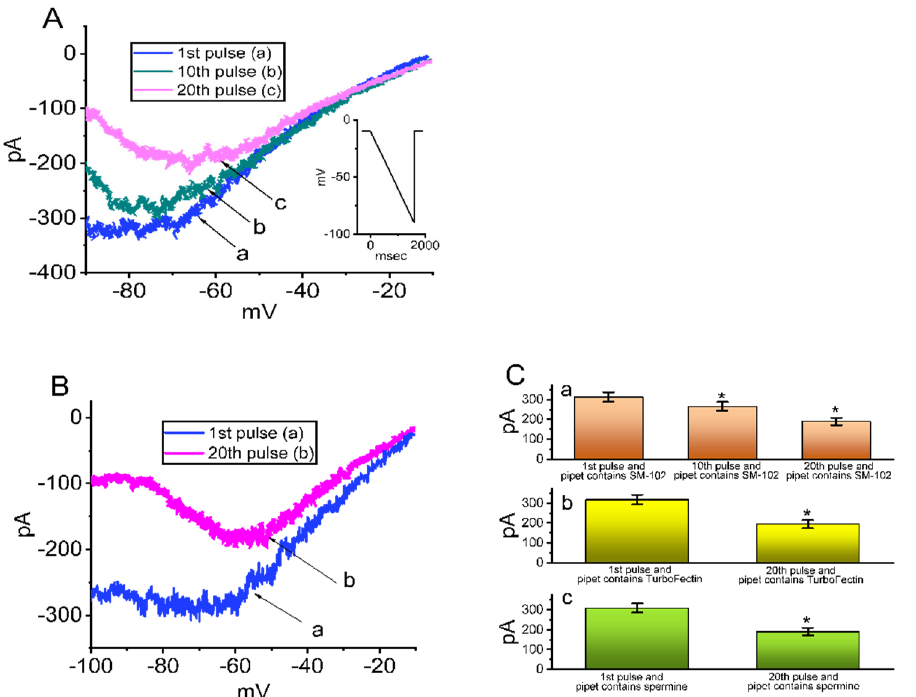
Figure 5. Effect of intracellular dialysis with SM-102, TurboFectin TM or spermine on I K(erg) in GH 3 cells. In this set of measurements, we filled the recording electrode with an internal solution which contained 100 µ M SM-102, 0.1% TurboFectin TM or 30 µ M spermine. In ( A ), as whole-cell mode was established, we applied a 2 s downsloping ramp pulse from − 10 to − 90 mV at a rate of 0.1 Hz. Inset at the right corner denotes the voltage-clamp protocol applied. In cells dialyzed with 100 µ M SM-102, current trace labeled a is the one when the first pulse was applied (i.e., immediately after membrane rupture occurred), while that labeled b or c was obtained at the 10th or 20th pulse, respectively. Of note, there was a progressive decrease in I K(erg) amplitude taken particularly at the voltages between − 90 and − 50 mV. In ( B ), cells were dialyzed with 0.1% TurboFectin TM , and the current trace labeled a or b activated by the same ramp pulse in ( A ) was taken at the 1st or 20th pulse, respectively. ( C ) Summary bar graph showing effect of intracellular dialysis with 100 µ M SM-102 (a), 0.1% TurboFectin TM (b) or 30 µ M spermine (c) on I K(erg) amplitude (mean ± SEM; n = 7 for the vertical bar in each panel). Data analysis in ( C a) was performed by ANOVA-1 ( p < 0.05), while those in ( C b) and ( C c) were by paired t -test ( p < 0.05). *Significantly different from control (i.e., the amplitude taken at the first